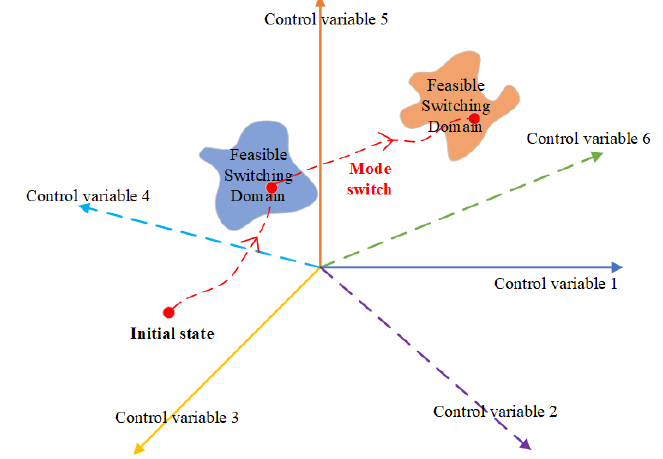
Figure 2. Mode switching process.